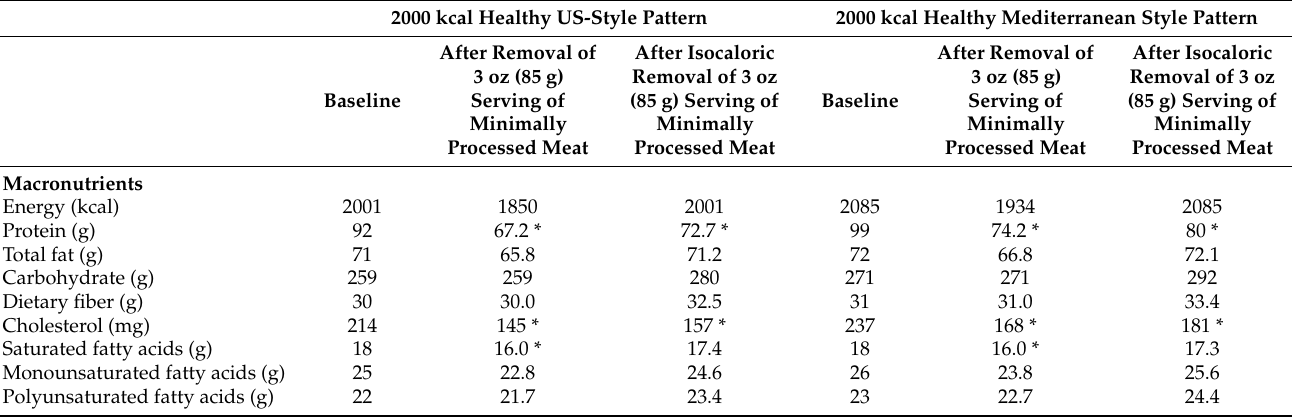
Table 4. Energy and nutrients in 2000 kcal Healthy Dietary Patterns before and after removal of a 3 oz (85 g) serving of minimally processed